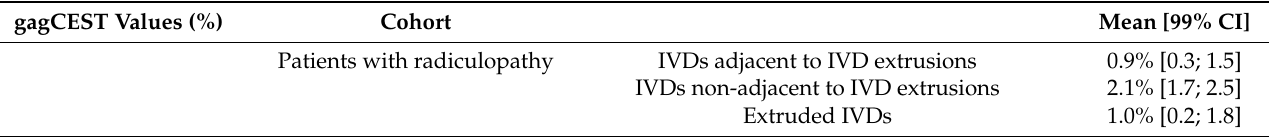
Table 4. Comparative analysis of glycosaminoglycan chemical exchange saturation transfer (gagCEST) values of interverte- bral discs (IVDs) adjacent to IVD extrusions and IVDs non-adjacent to IVD extrusions of patients with radiculopathy. Data are means [99% confidence intervals]. The mean gagCEST values were compared with a linear mixed model comprising a subject-specific random